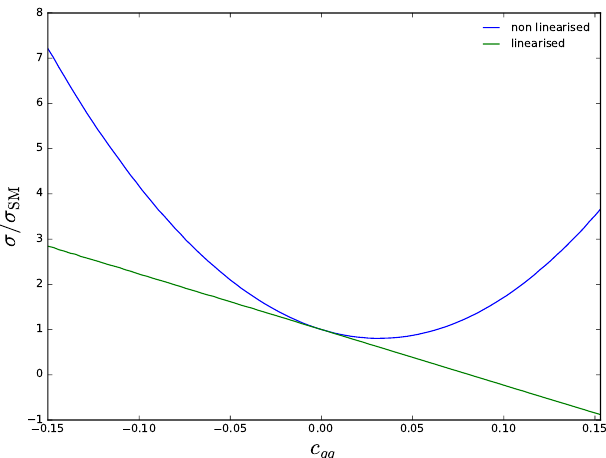
Figure 1 . Total cross section for Higgs boson pair production at LO as a function of c gg , both for the linearised and non-linearised